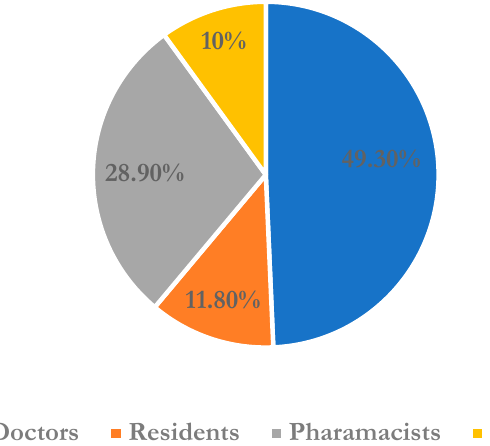
Figure 2. Healthcare professionals categorized according to their occupation (N = 491).